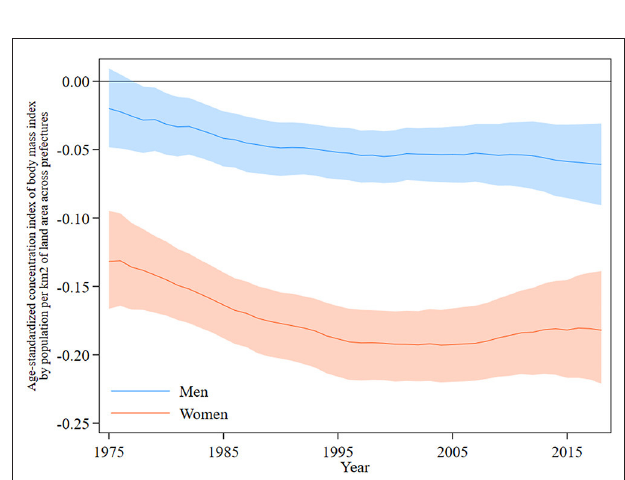
FIGURE 3 | Concentration index for the total body mass index across the 47 prefectures of Japan in each year from 1975 to 2018, by sex. The height of the shaded area shows the 95% credible